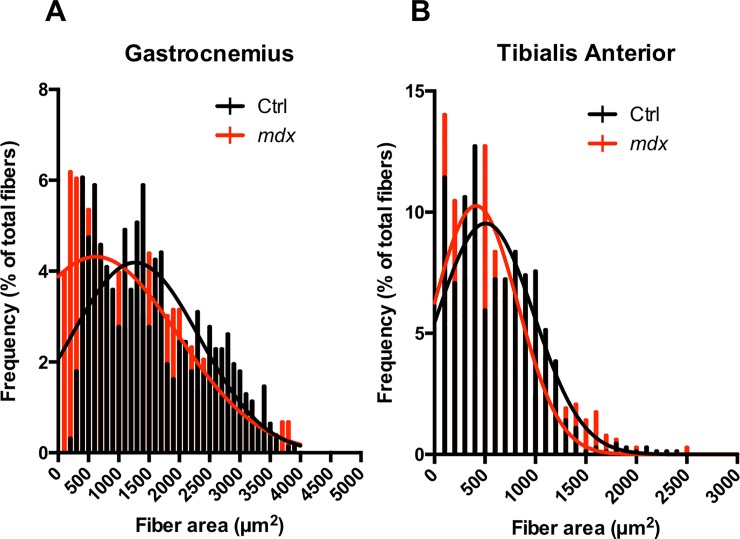
Histogram Analysis for individual muscle fiber area of TA and GA muscle fibers in 11-week old mdx4cv and control mice.Muscle fiber areas measured for the TA and GA muscle differences between groups. Area values were binned into intervals of 500 μm2 and overlaid for both frequency and distribution comparisons.